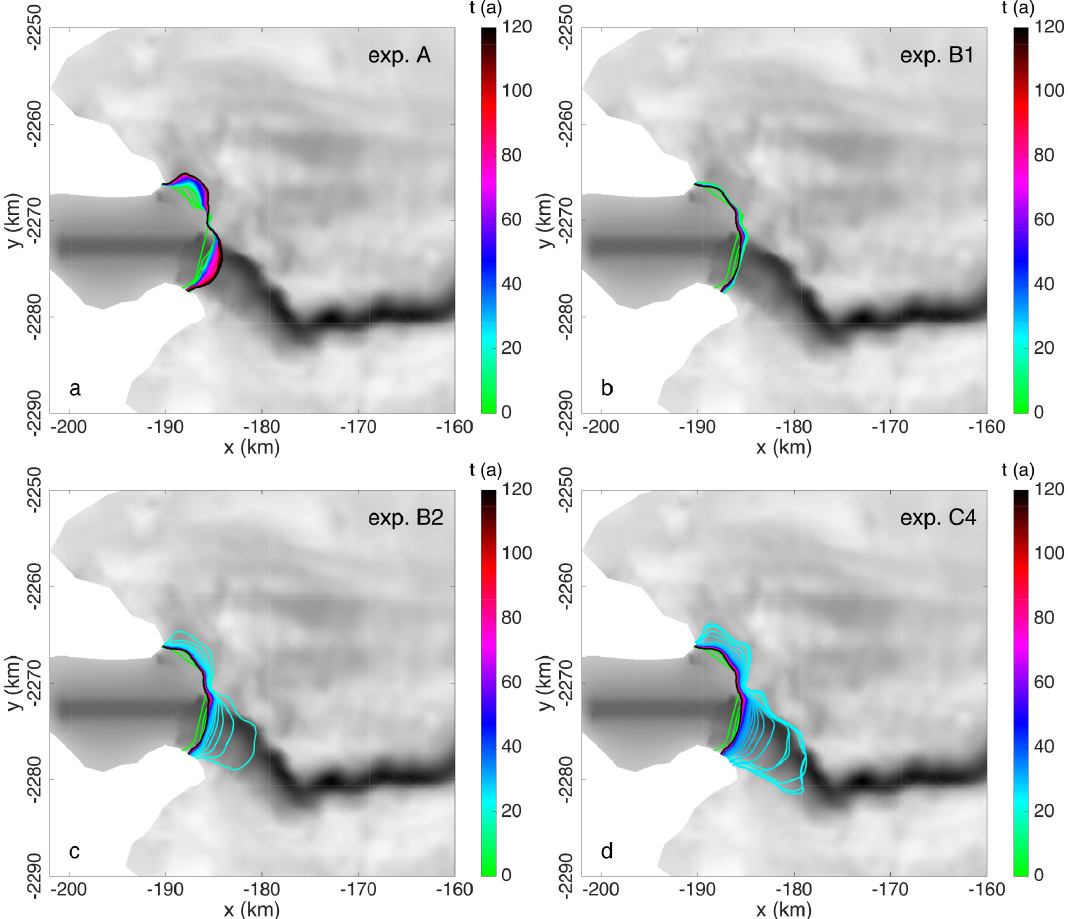
Figure 5. Calving front positions for experiments A, B1, B2, and C4 at the start of each year, plotted over basal topography (grey).